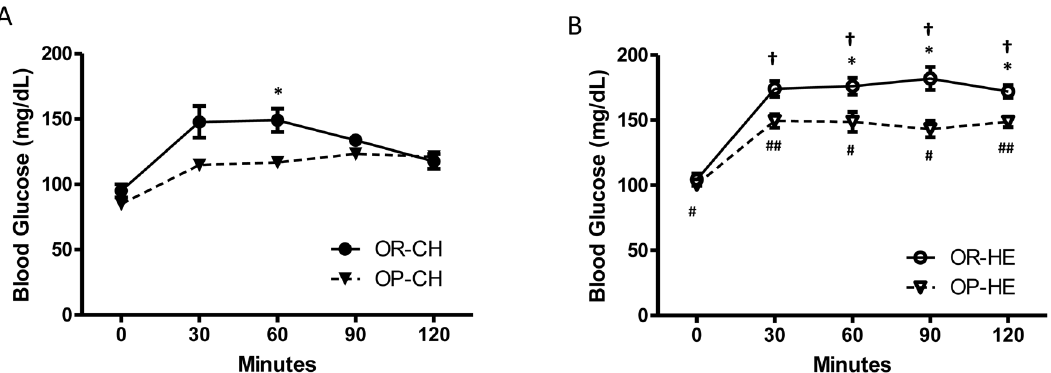
Figure 4. OGTT of OP and OR rats during chow- and HE-feeding. During chow-feeding, OP rats had reduced blood glucose levels at 60 min compared to OR rats, while HE-fed OP rats exhibited reduced glucose levels at 60, 90, and 120 min compared to HE-fed OR rats. *P , 0.05 OP relative to OR within diet condition; { P , 0.05 HE-OR relative to chow-OR; # P , 0.05, ## P , 0.001 HE-OP relative to chow-OP.